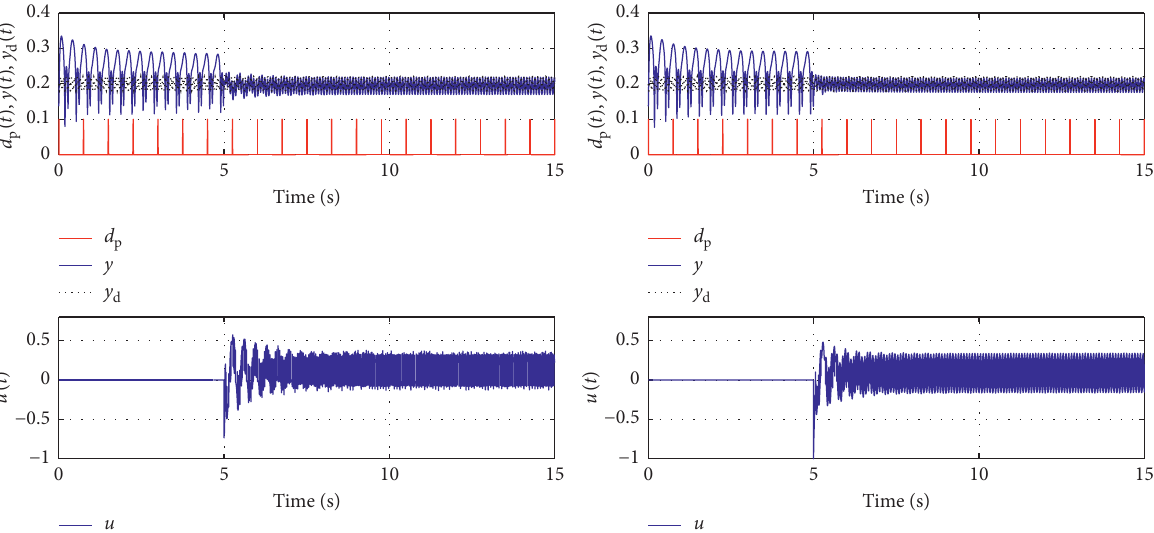
Figure 15: Control performance of NN-FOSM and NN-FFOSM in case 1.